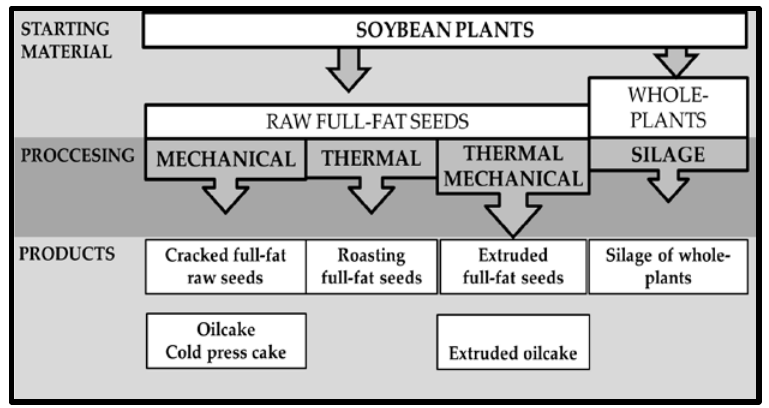
Figure 1. Processing of soybean seeds and whole soy plants into soybean products for feeding cattle on small farms.